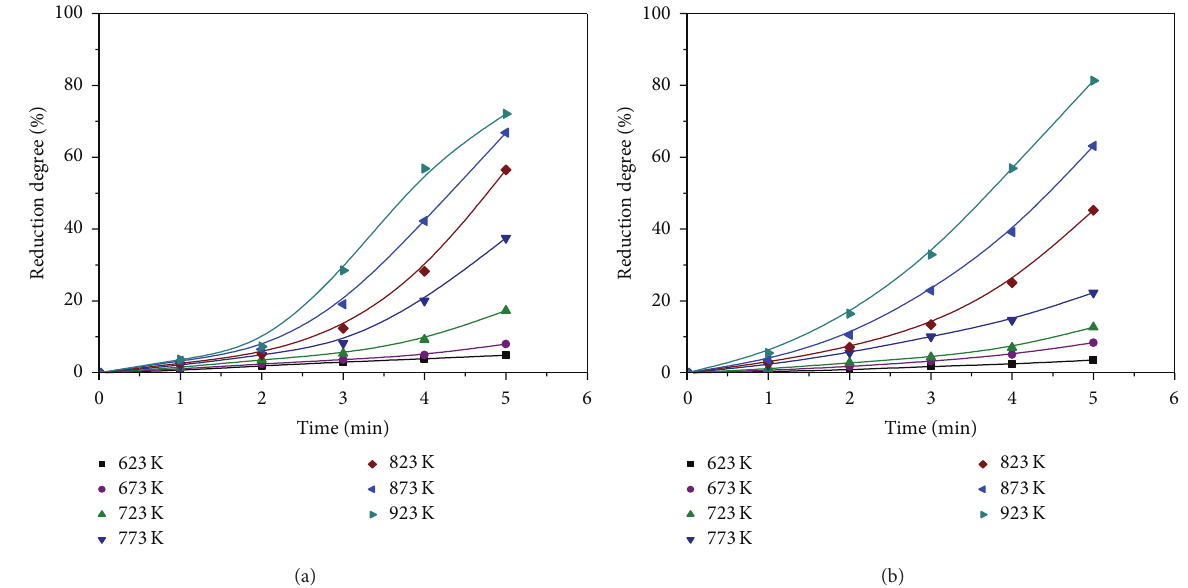
Figure 2: Effect of reduction temperature and time on the reduction degree of (a) NiO and (b) NiCl 2 .